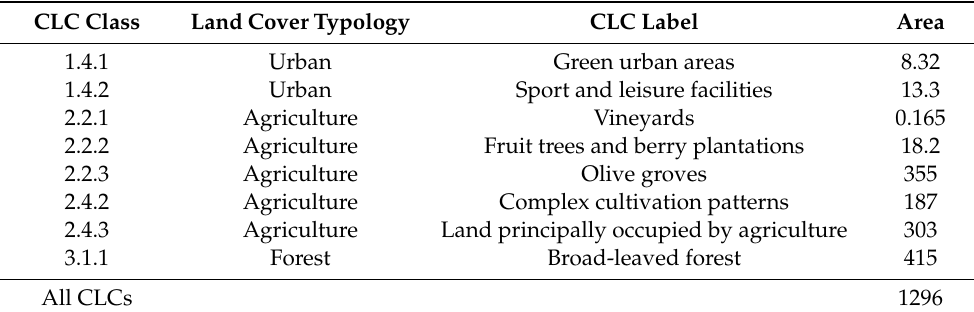
Table 2. Corine Land Cover level 3 classes, labels, and their spatial extent in the study